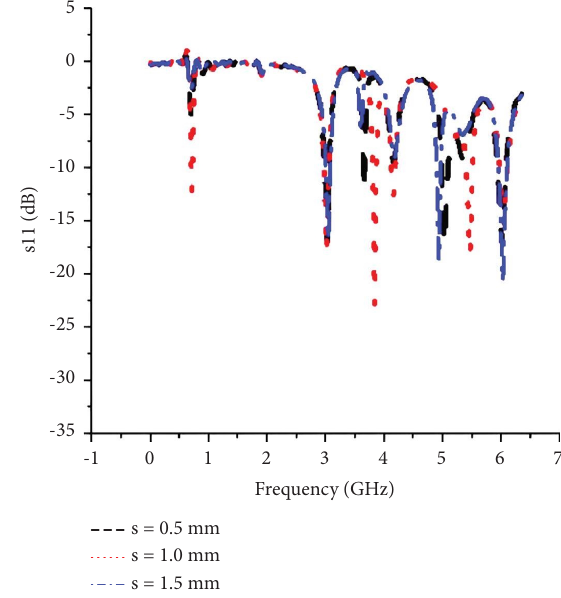
Figure 6: S 11 comparison plot for various values of ring separation.